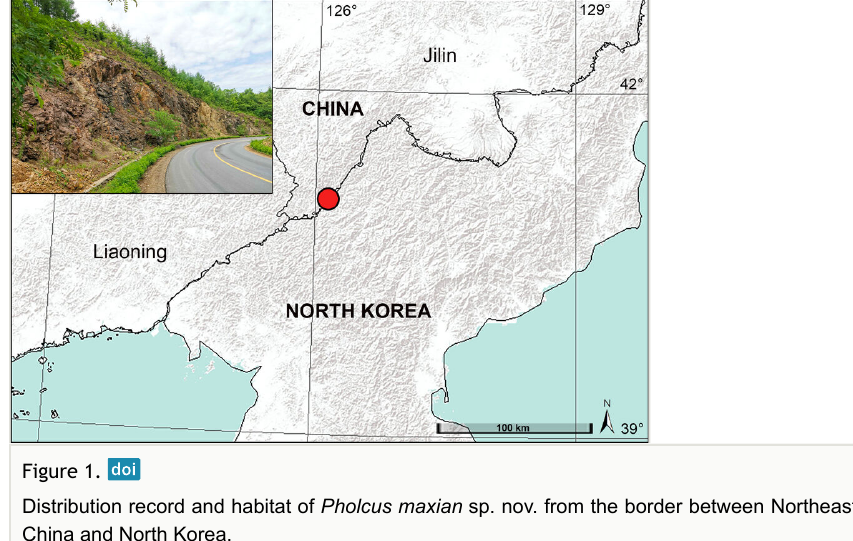
Distribution record and habitat of Pholcus maxian sp. nov. from the border between Northeast China and North